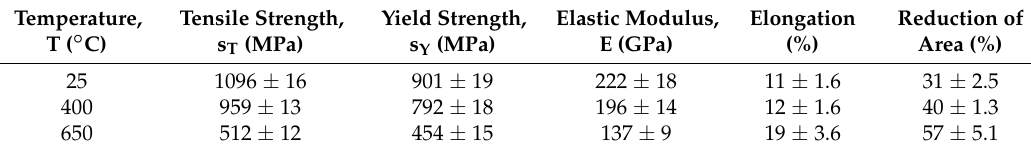
Figure 3. Microstructure of the 42Cr9Si2 steel. ( a ) tempered martensite; ( b ) enlarged view of clearer grain boundaries. Table 3. Mechanical properties of the 42Cr9Si2